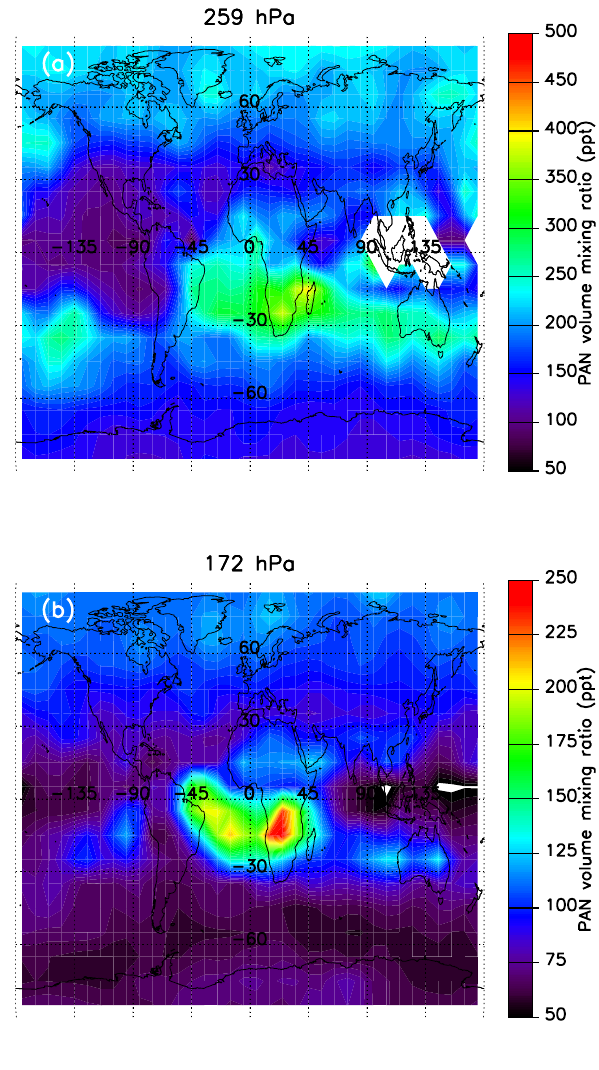
Fig. 9. Global PAN distributions (in units ofpptv) at average pres- sure levels of 259hPa (a) and 172hPa (b) averaged for the month of October 2003. White areas are cloud contaminated